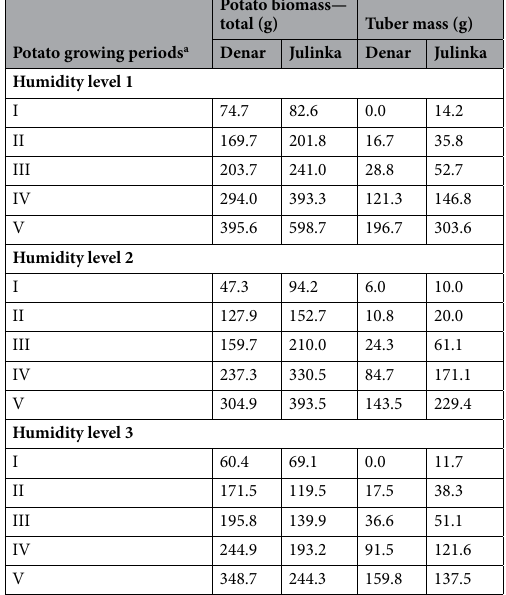
Table 2. Potato total biomass and tuber increase depending on water humidity level (g per plant). a Explanation under Table